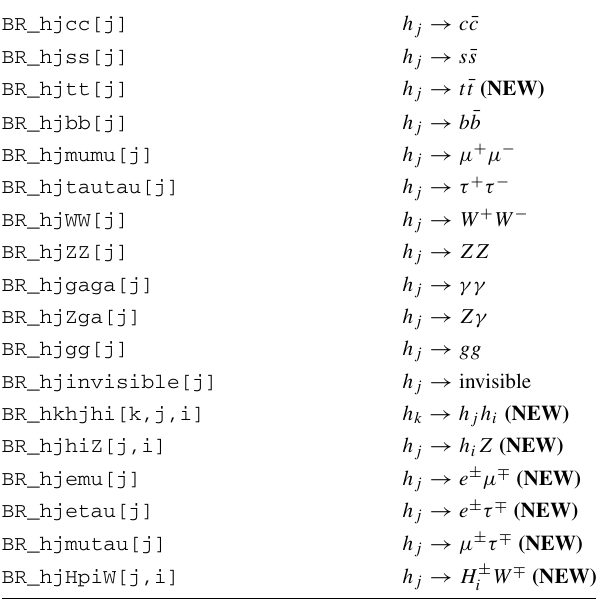
Table 3 Branching ratios for neutral Higgs bosons. Possible decay modes for a SM-like Higgs bosons are on the left and decays involv- ing new physics or flavor violation on the right. Quantities added in HiggsBounds-5 are labeled as